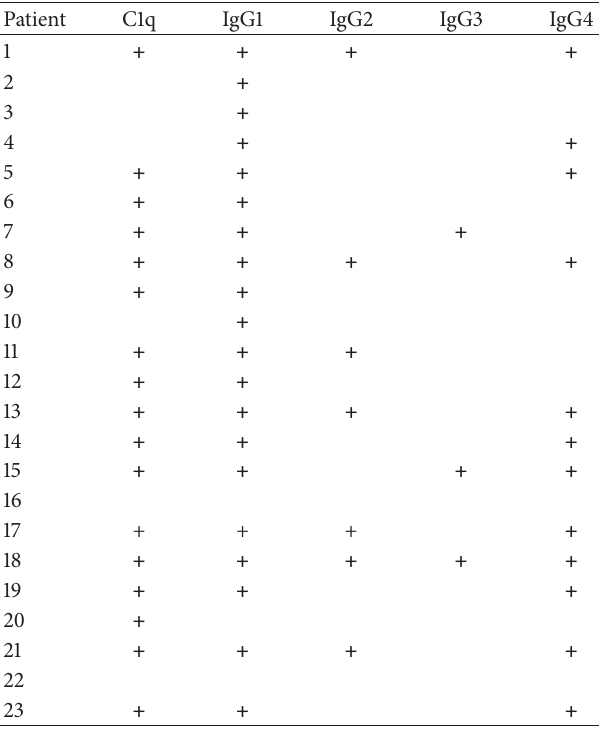
Table 10: DSA detected by C1q and IgG